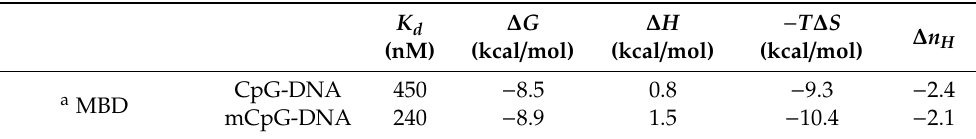
Table 4. Bu ff er-independent binding parameters for the interaction of the di ff erent MeCP2 variants with unmethylated (CpG-) and methylated (mCpG-) dsDNA at pH 7 and 20 ◦ C.